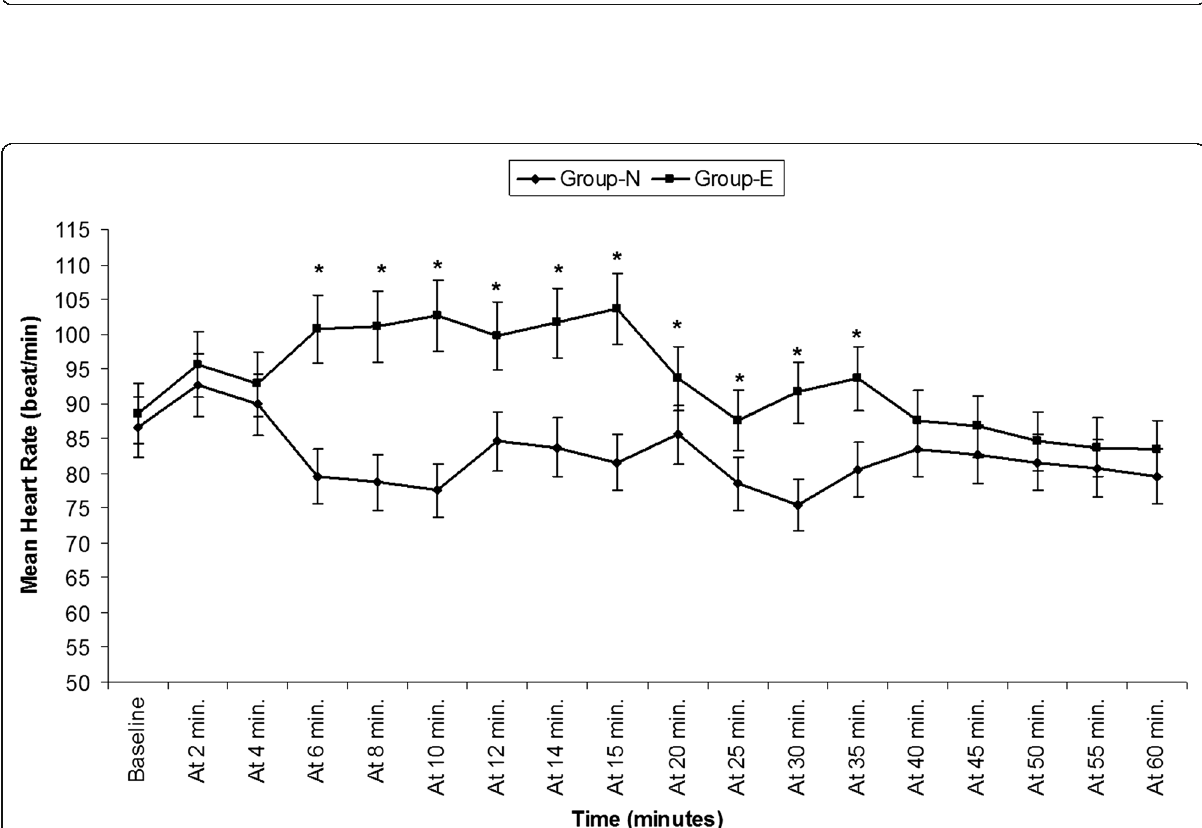
Fig. 1 Comparison between norepinephrine group and ephedrine group according to mean arterial blood pressure